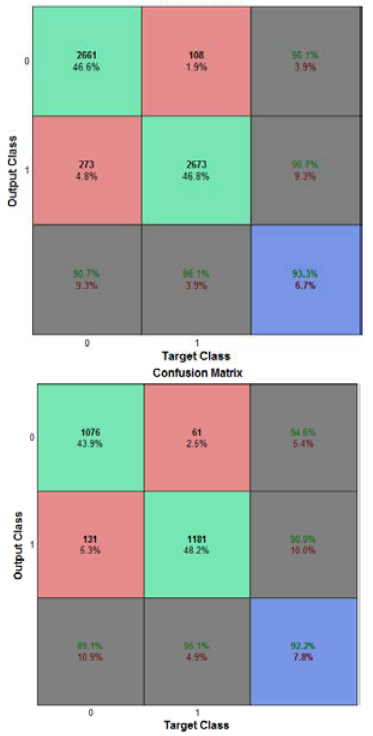
Figure 6. Validation of training and testing data